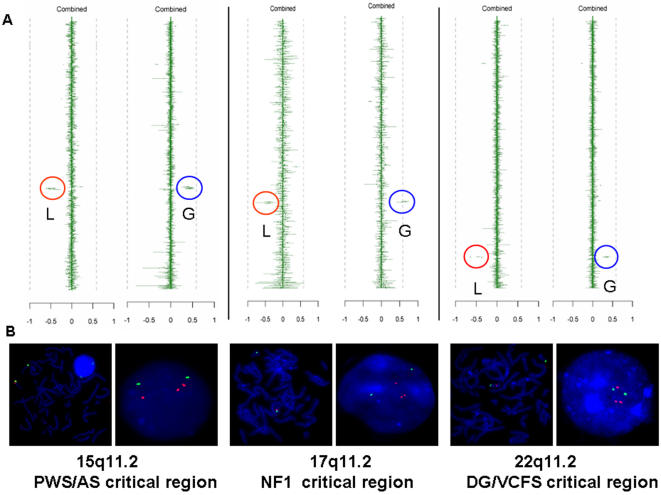
Example of reciprocal deletion/duplication CMA ratio plots with FISH validation. A Three sets of ratio plots showing examples of reciprocal microdeletion and microduplication at PWS/AS (on V5), NF1 (on V4) and DGS/VSFS (on V5) critical regions on chromosomes 15q11.2, 17q11.2 and 22q11.2, respectively. The vertical lines represent the BAC clones interrogating targeted regions of the genome, aligned according to their chromosomal position with the signal intensity ratios observed from the combined dye-swap experiments. Gains (G) are to the right and losses (L) to the left. Red circles highlight the signal ratios revealing genomic losses whereas the blue circles indicate copy number gains consistent with genomic deletions and reciprocal duplications, respectively. B FISH validation results. Control probes were labeled with a green chromophore and clones detecting deletions (in metaphase) or duplications (in interphase) were labeled in red for PWS/AS del/dup, NF1 del/dup and DG/VCFS del/dup.